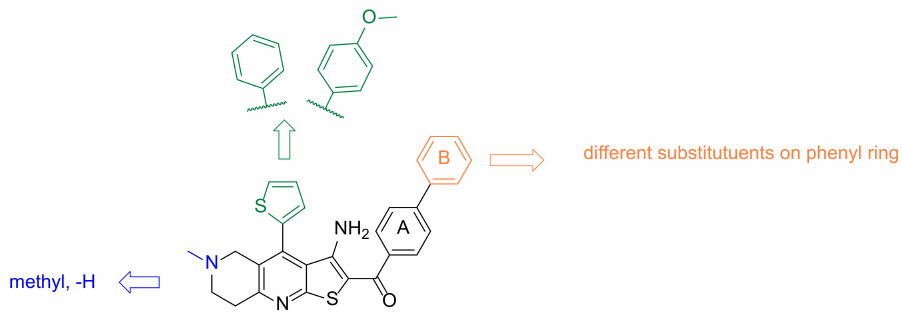
Figure 6. Design strategy for optimisation of compound TVS-23